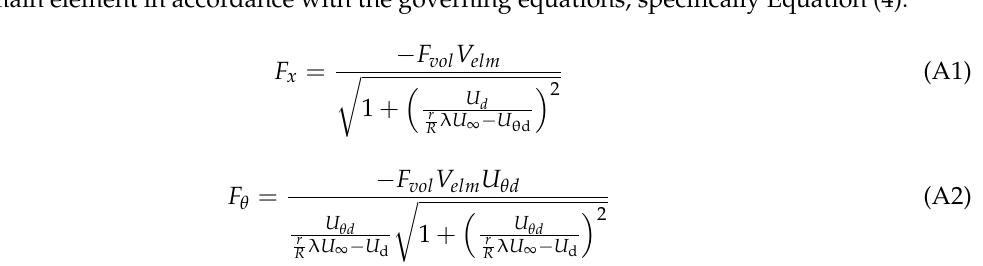
Figure A2. Computational domain and mesh topology for step 1. ( Left ): Entire domain. ( Right ): Zoom-in on mesh topology around disk.